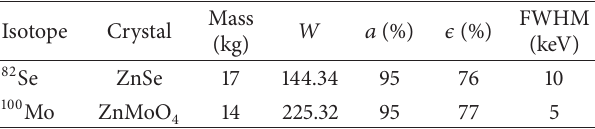
Table2:LUCIFERexperimentalparametersforthetwobaseline0 ] - DBD candidates. For each isotope, we quote the type of scintillating crystal, the total detector mass, the molecular weight of the active mass( 𝑊 ),theisotopicabundanceassumingenrichment( 𝑎 ),theeffi- ciency, and the energy